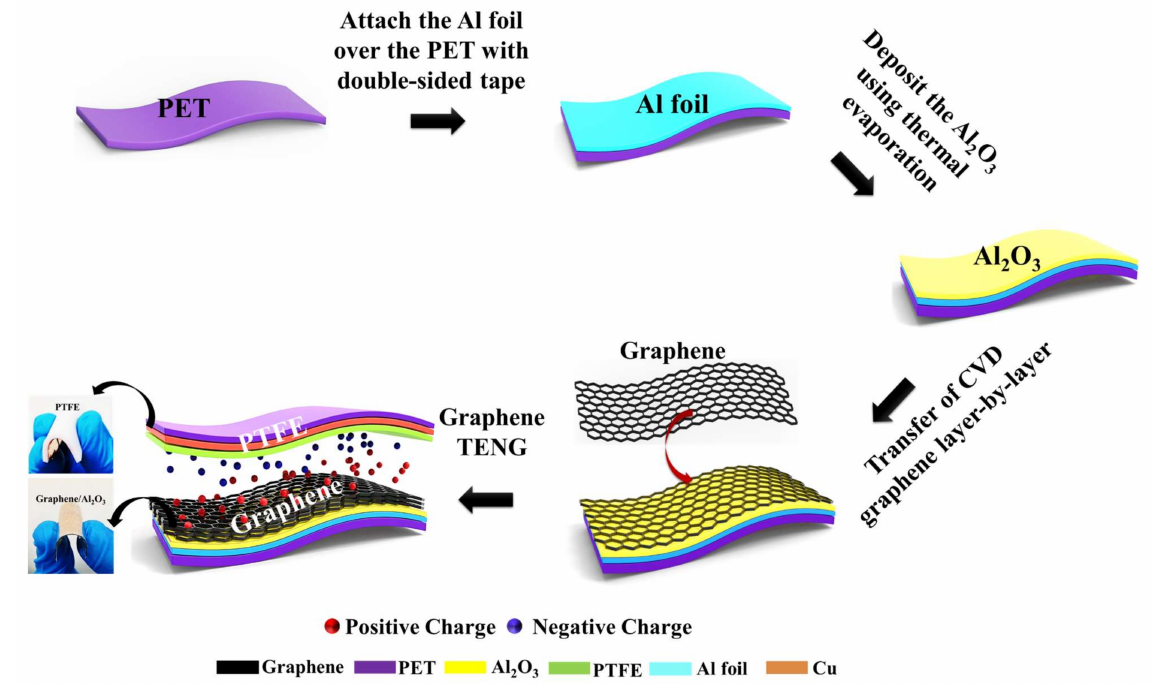
Figure 1. Schematic illustration showing the fabrication process of a flexible Gr-TENG with Al 2 O 3 as the